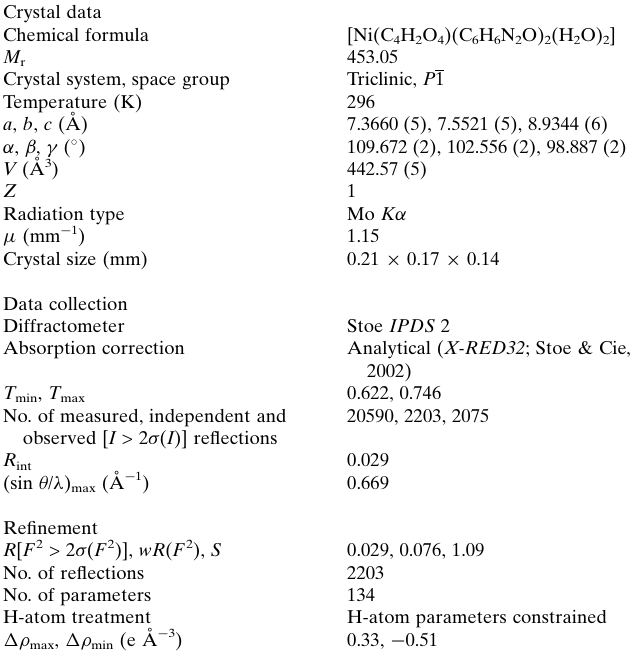
Table 2 Experimental details. Crystal data Chemical